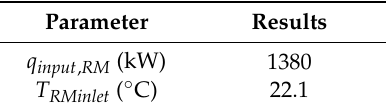
Table 2. Additional inputs in the